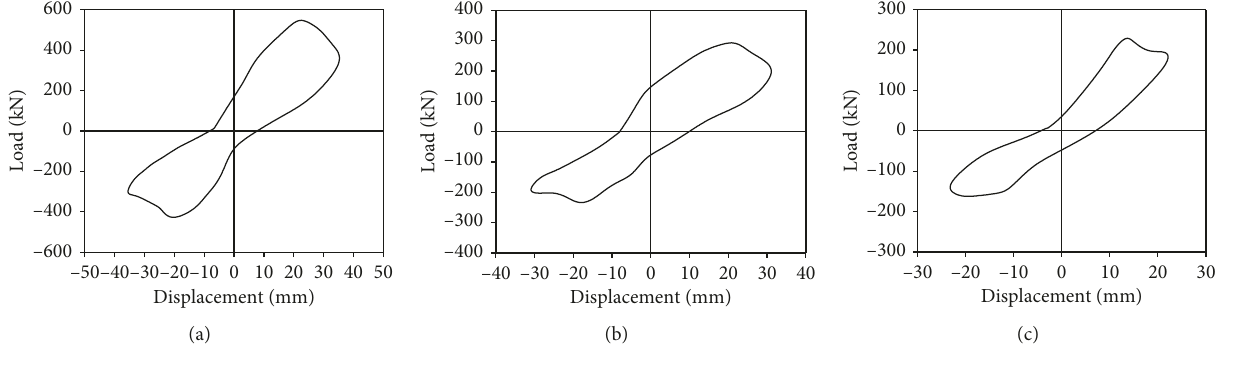
Figure 13: The envelopes of load-displacement hysteresis curves.